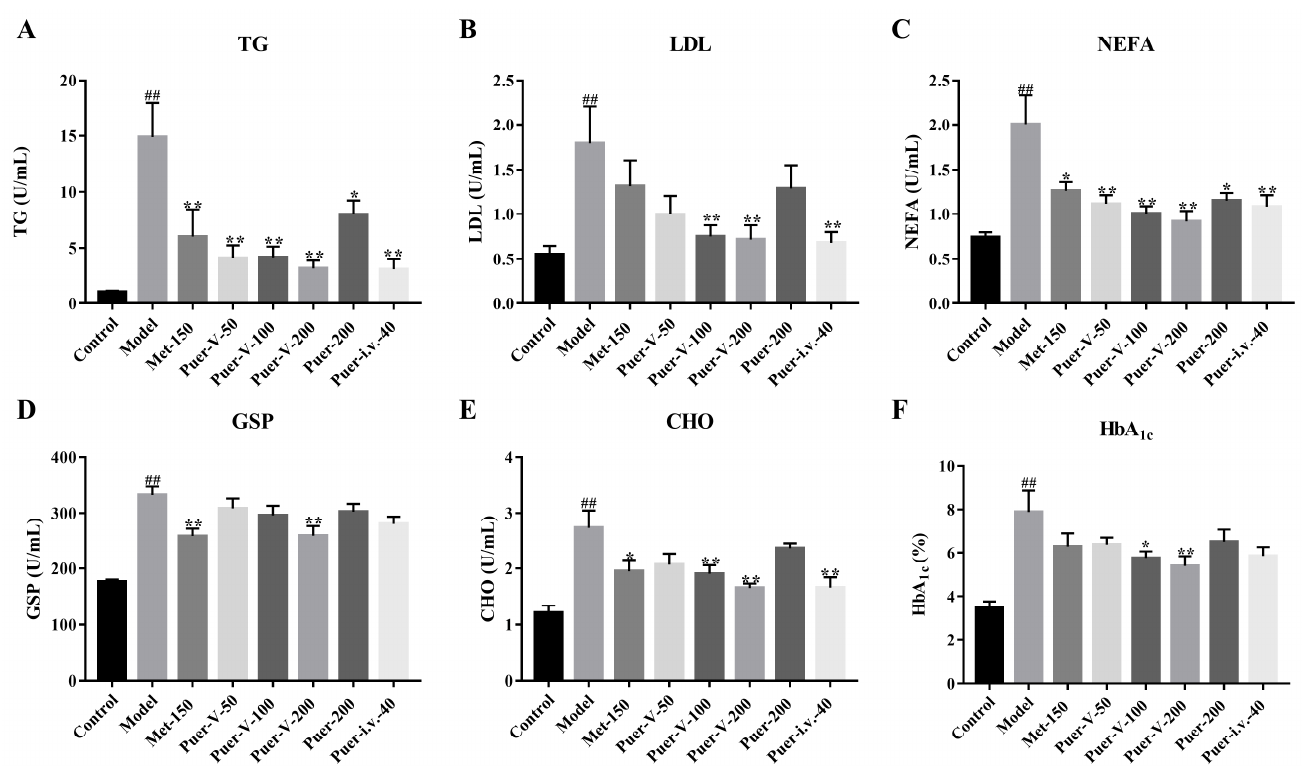
Figure 2. Puerarin-V modulated lipid metabolism disturbances. The serum levels of ( A ) TG, ( B ) LDL, ( C ) NEFA, ( D ) GSP, ( E ) CHO, and ( F ) HbA1c were measured. The data are represented by mean ± SEM (n = 6–8). ## p < 0.01 vs. control group. * p < 0.05 and ** p < 0.01 vs. model group.